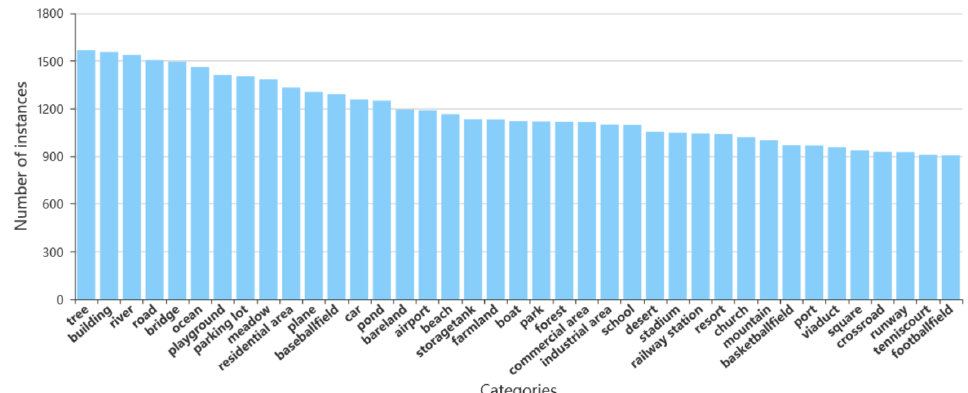
Figure 8. Quantity distribution of the main categories on RSSGD.